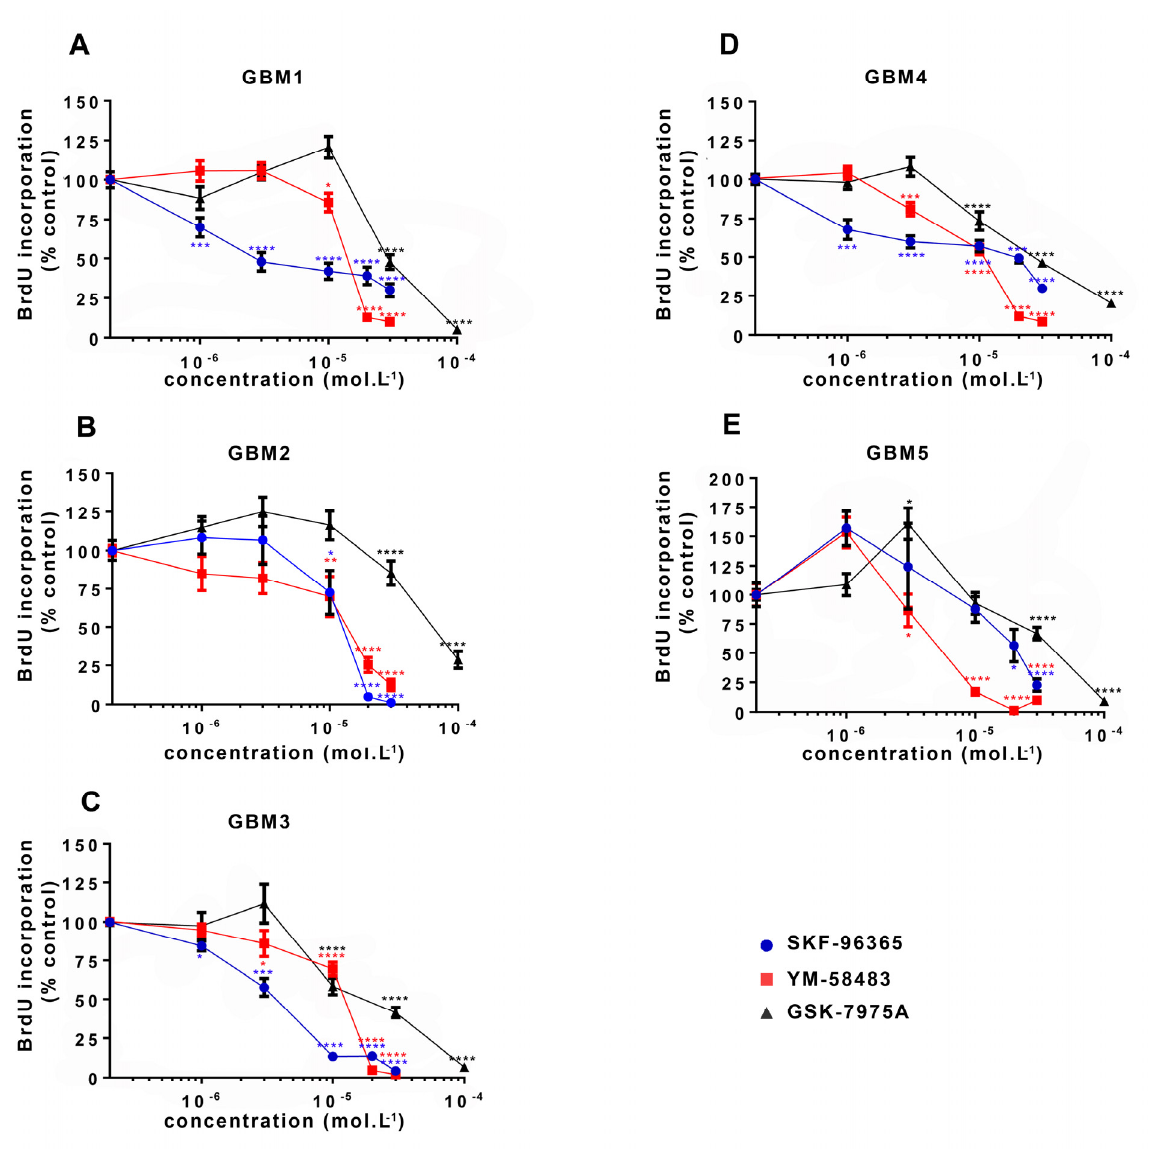
Figure 3. Pharmacological inhibition of SOC reduces GSC proliferation. Percentages of BrdU (bromodeoxyuridine) incorporation (expressed as percentage of control) in GSC cultures (( A – E ): GBM1-GBM5) maintained for 24 h with increasing concentrations of SKF-96365 (blue), YM-58483 (red) or GSK-7975A (black). Data represent means ± s.e.m of four independent experiments, with each condition assessed in quadruplicate per experiment. * p < 0.05, ** p < 0.01, *** p < 0.001, **** p <